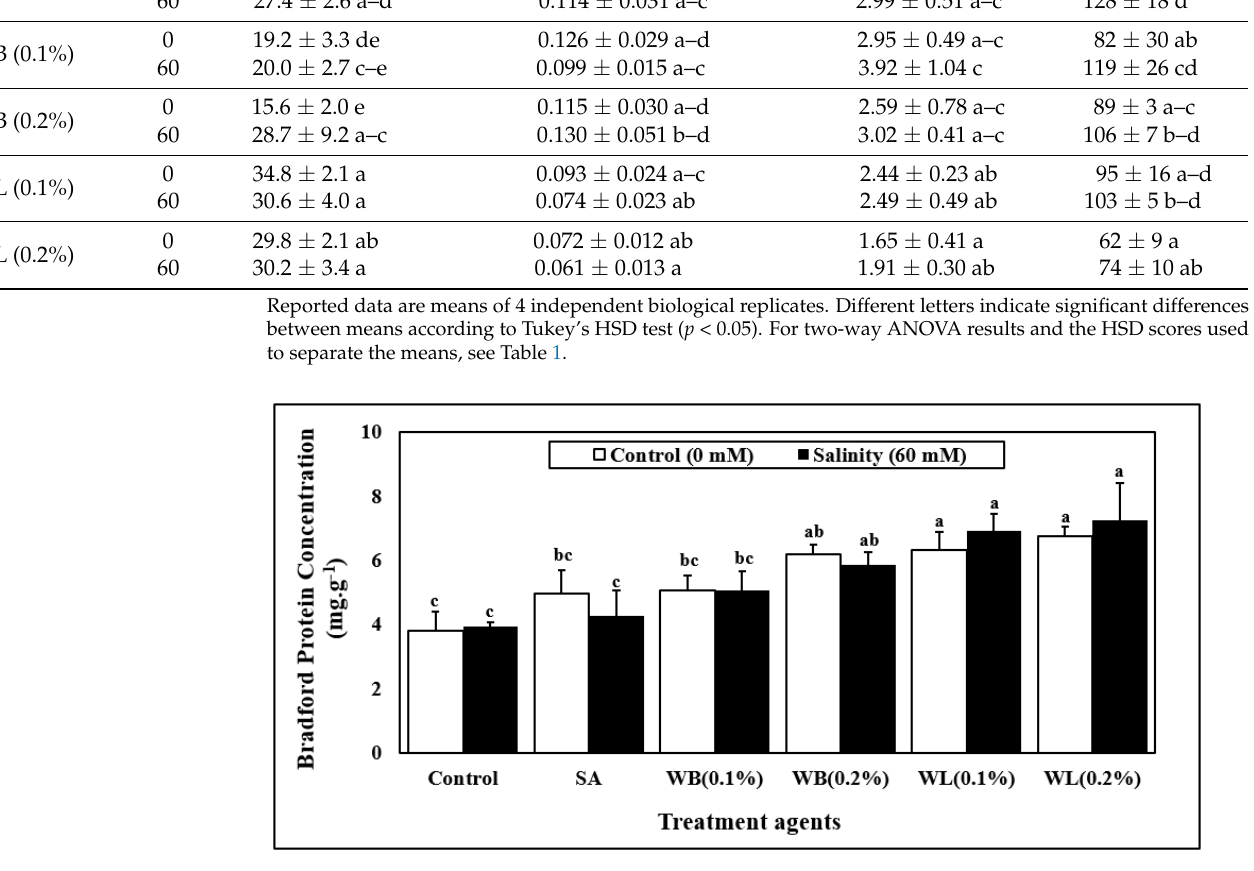
Table 4. Changes in shoot Na, K concentrations and Na/K ratio of 30 day-old hydroponically grown maize ( Zea mays cv. Caramelo) plants in response to salinity (non-salinity stress, 0 mM; salinity stress, 60 mM) and biostimulant applications (SA, salicylic acid (25 µM); WB, willow bark extract (0.1% or 0.2% w/v ); WL, willow leaf extract (0.1% or 0.2% w/v )).